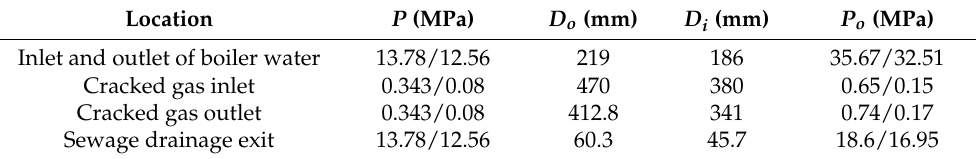
Table 2. Data used to calculate equivalent tube loads.